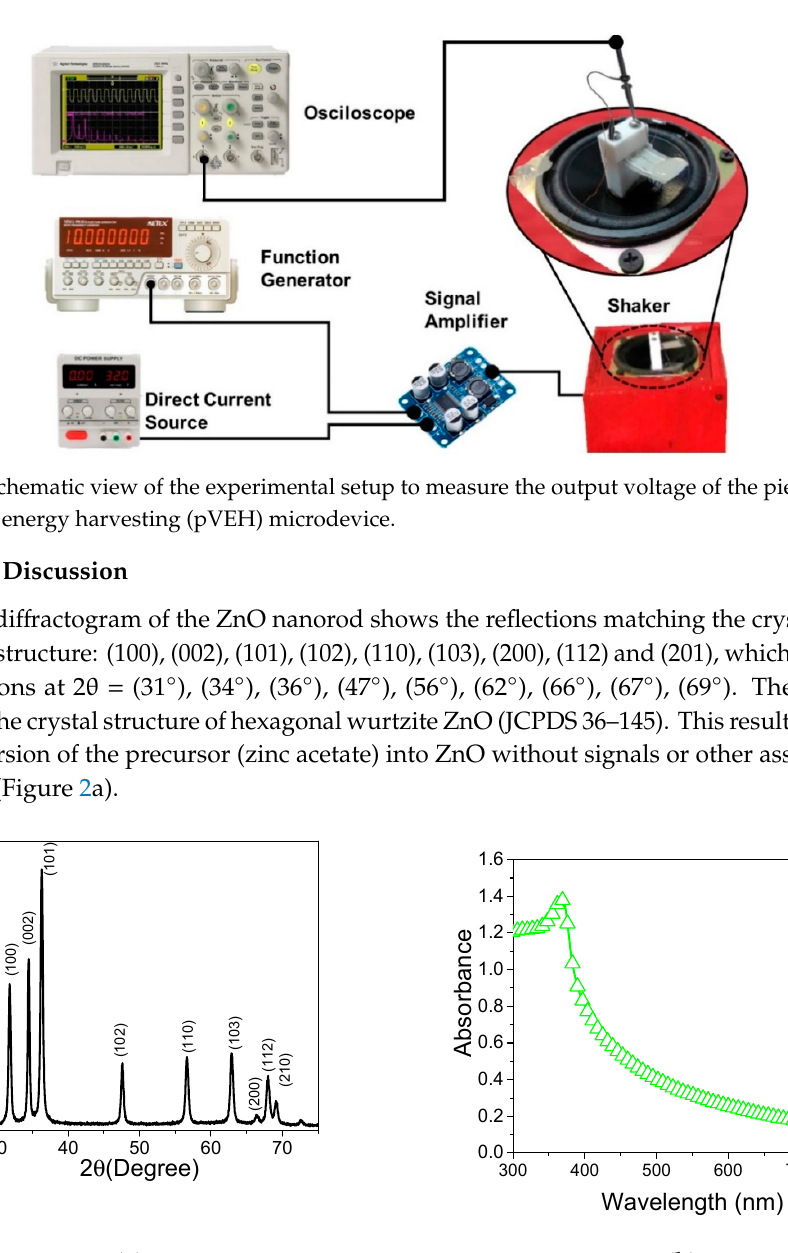
Figure 2. ( a ) XRD diffractograms of ZnO nanorod film and ( b ) absorption spectra of ZnO nanorod film.